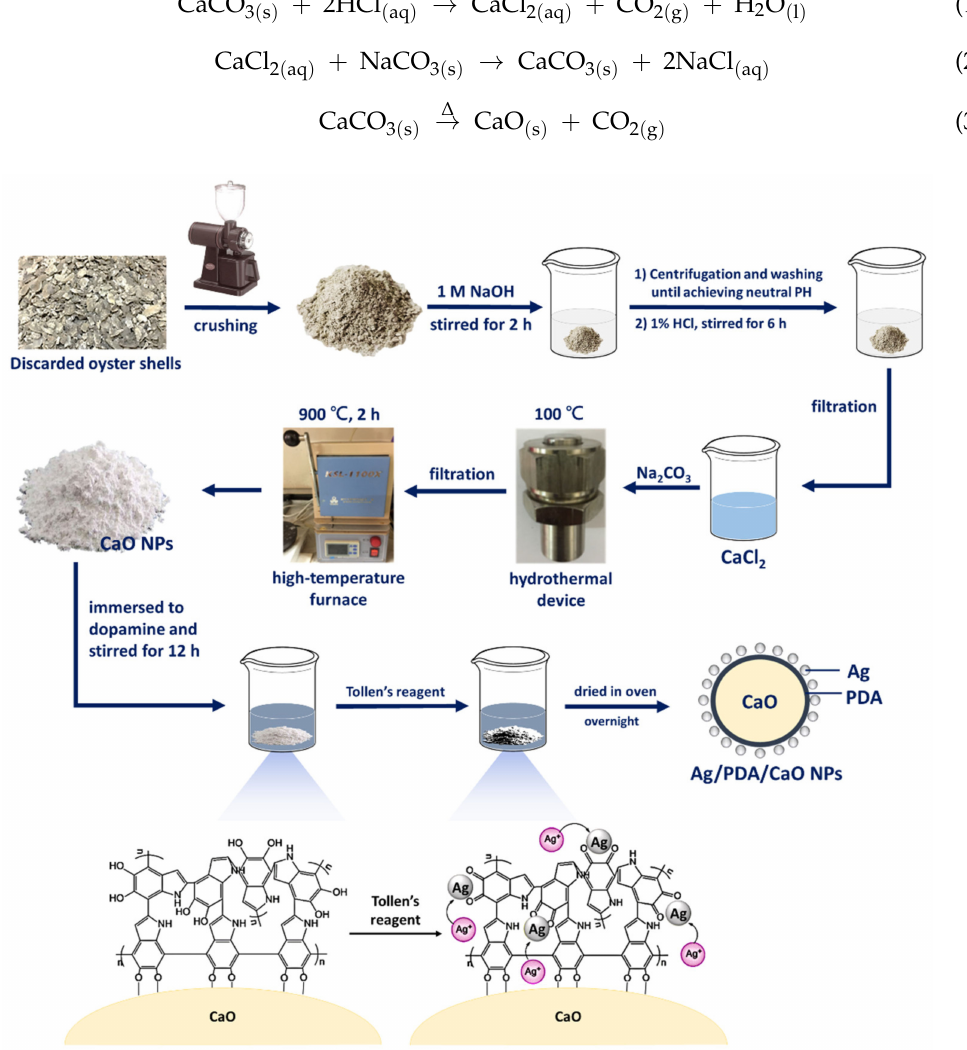
Scheme 1. Preparation process of Ag/PDA/CaO